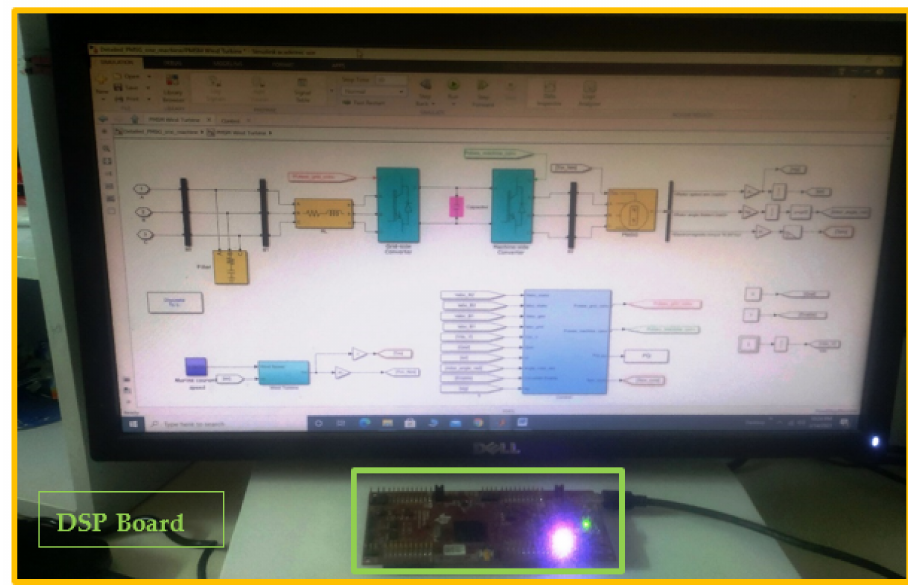
Figure 20. Experimental DSP